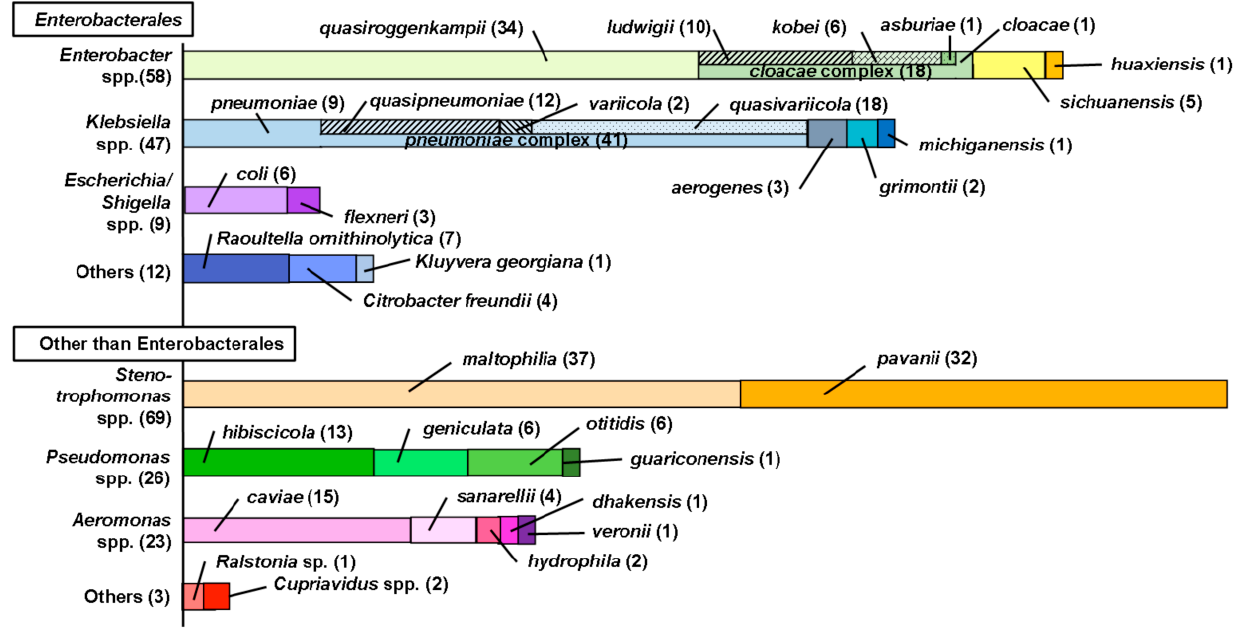
Figure 3. Identified species of presumptive CRE isolates based on 16S rRNA sequencing. Among the identified isolates in Klebsiella spp., K. pneumoniae , K. quasipneumoniae , K. variicola, and K. quasivariicola were categorized into a K. pneumoniae complex [25]. Only three isolates were identified as K. aerogenes , an important species in CRE. Seven